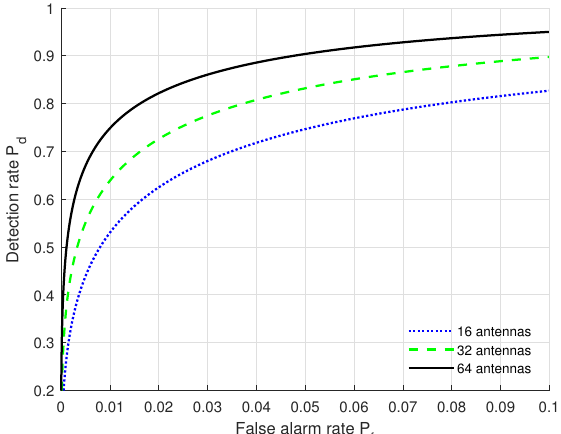
Figure 3. ROC curves under different numbers of receiver antennas with the settings of (SNR = 10 dB, L = 20, k φ = 2 dB, k θ = 2 dB, k α = 2 dB).